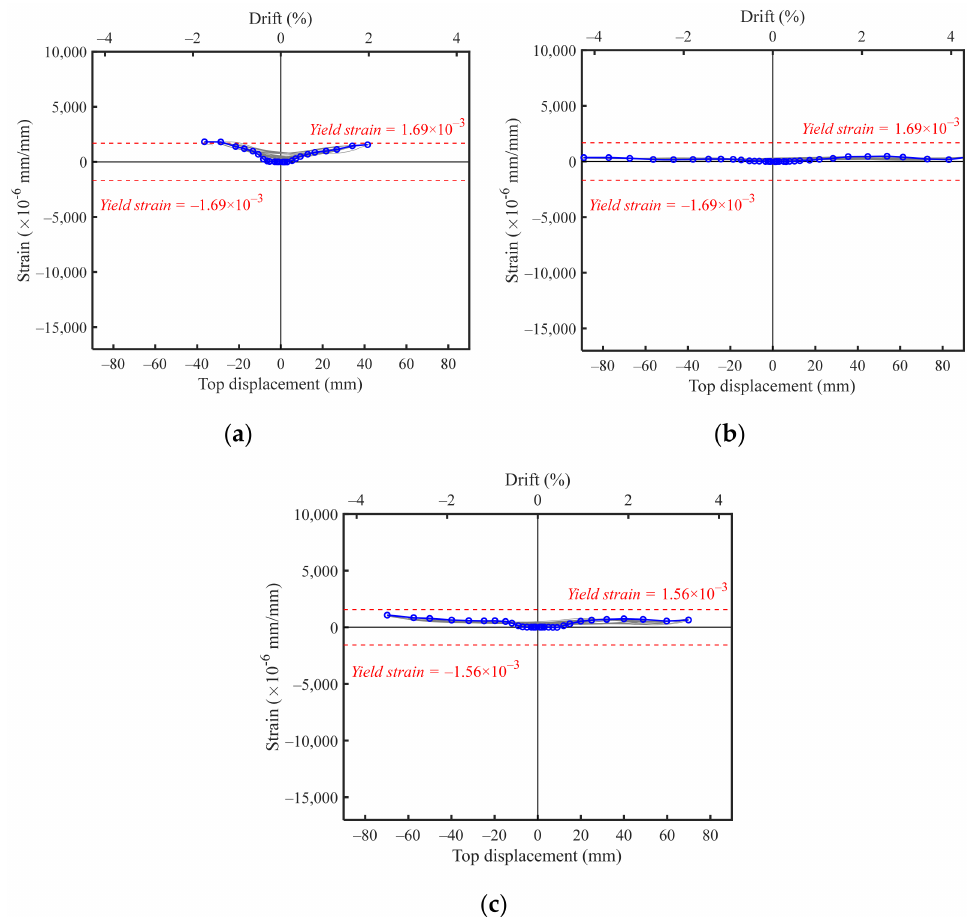
Figure 19. Strain response of horizontal bars. ( a ) W0 (No. 2 gauge in Figure 10); ( b ) W1-R (No. 2 gauge in Figure 10); ( c ) W2-R (No. 3 gauge in Figure 10).